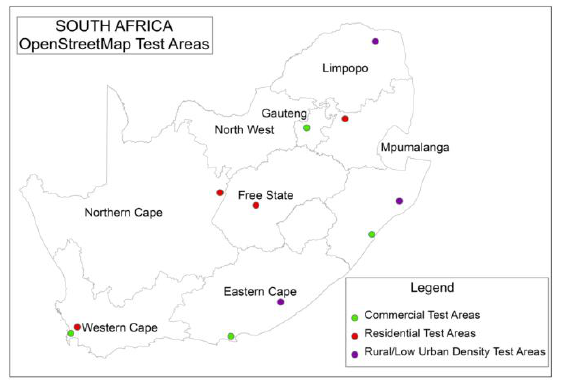
Figure 3 Location of areas in South Africa from which the test areas are drawn.